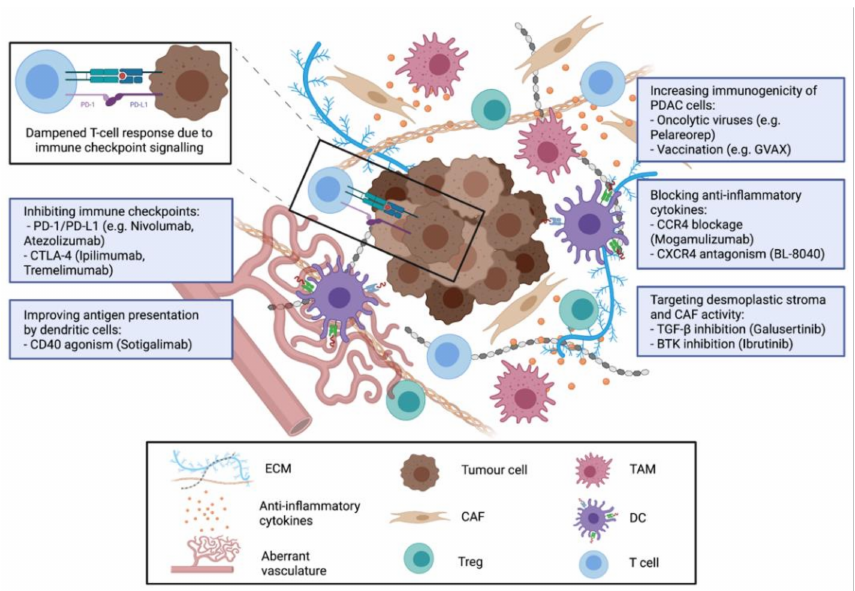
Figure 1. Therapeutic strategies to target immunosuppressive components of the TME in PDAC. Ab- breviations: Extracellular matrix (ECM); cancer associated fibroblasts (CAF); regulatory T-cells (Treg); tumour associated macrophages (TAM); dendritic cells (DC). Figure created with